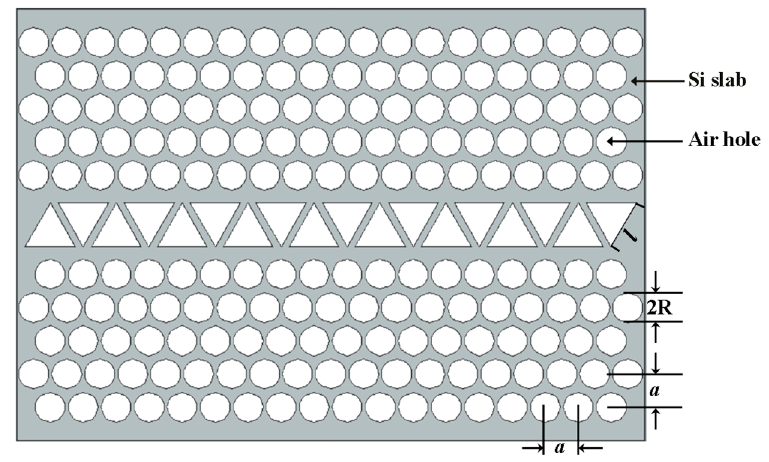
Figure 1. Schematic diagram of the proposed EPCW structure.